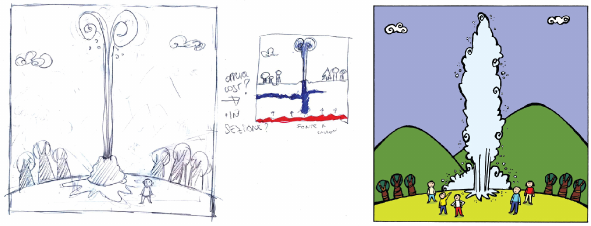
Figure 1. Memory graphic draft for the geyser playing card. The artist proposed two different solutions to the researcher and to- gether decided on the final illustration (illustration made by Con- suelo Zatta).